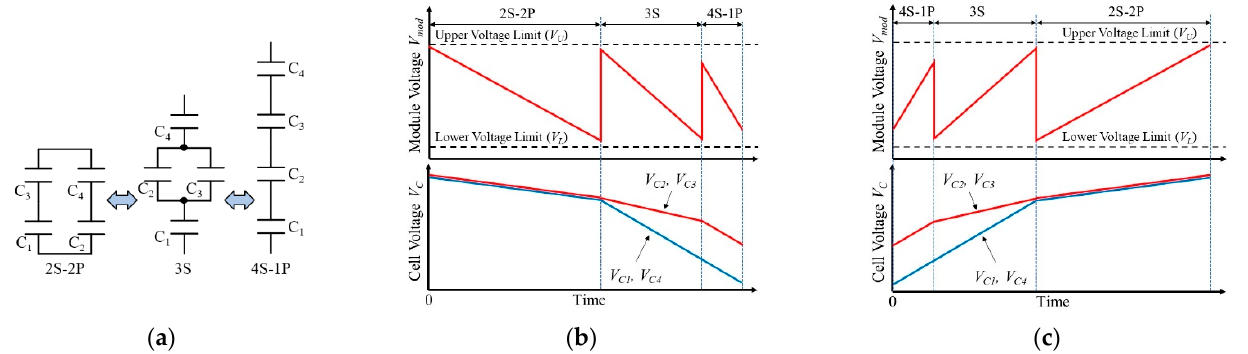
Figure 5. ( a ) Reconfiguration sequence of unbalance-shift circuit for four-cell module, and its ( b ) discharging and ( c ) charging profiles.